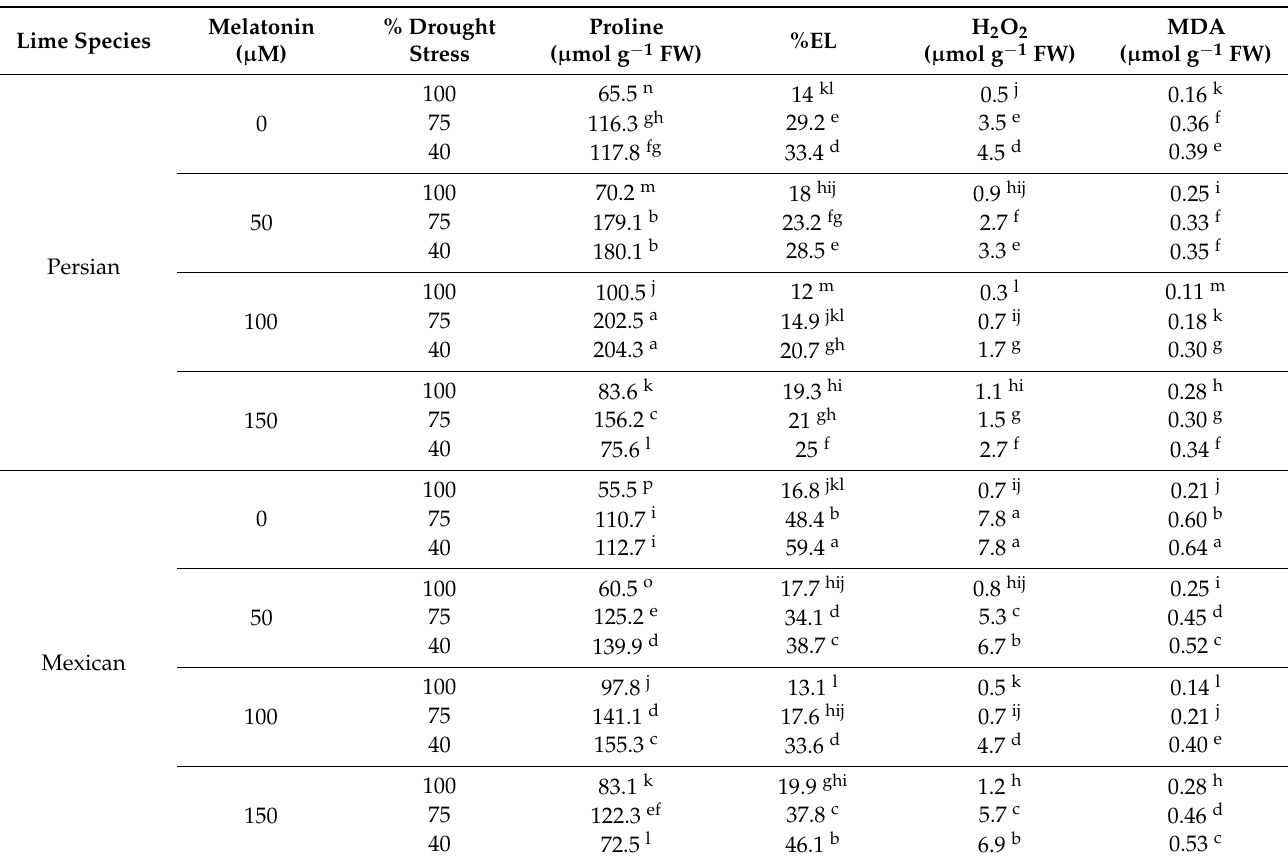
Table 2. Effect of melatonin concentrations, lime species, and percentage of drought stress on biochemical responses including proline content, percentage electrolyte leakage (%EL), hydrogen peroxidase (H 2 O 2 ) and malondialdehyde